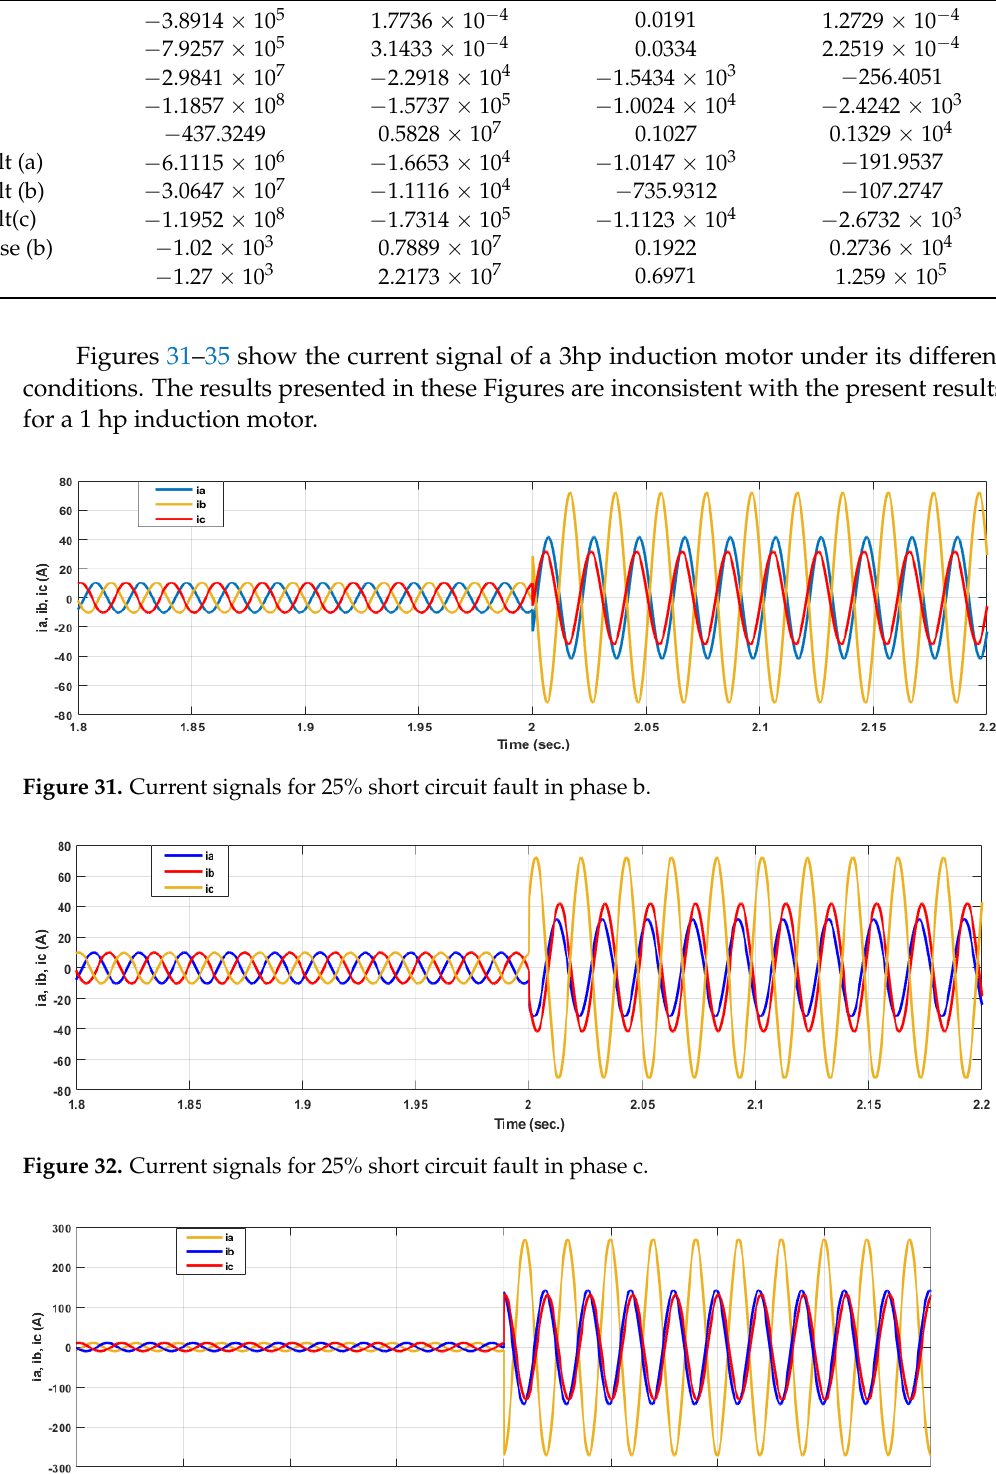
Figure 34. Current signals for 25% short circuit fault in phase a. Figure 35. Current signals for 50% short circuit fault in phase a. The maximum scan rate of labjack is equal to 50 k samples/s per the number of chan- nels used. In this experiment, three channels of the labjack were used. Therefore, the max- imum sampling rate is 16.67 k samples/s per channel. Using a scan rate of 2500 samples per channel per second, the number of samples for each cycle can be calculated as follows. sample⁡rate = scan⁡rate × number⁡of⁡channels⁡ × time⁡for⁡one⁡cycle